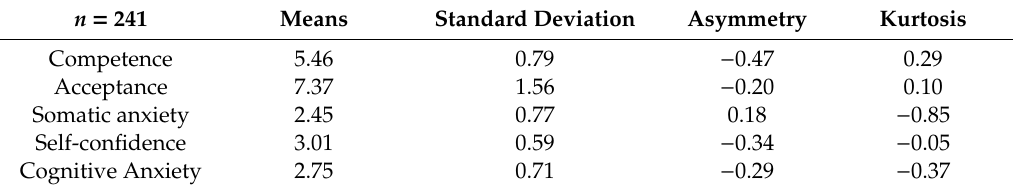
Table 2. Means, standard deviations, and measures of dispersion of the variables studied for the sample. n = 241